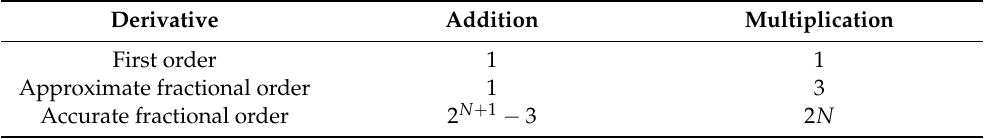
Table 2. The addition and multiplication complexity of the first order, the approximate fractional order, and the accurate fractional order